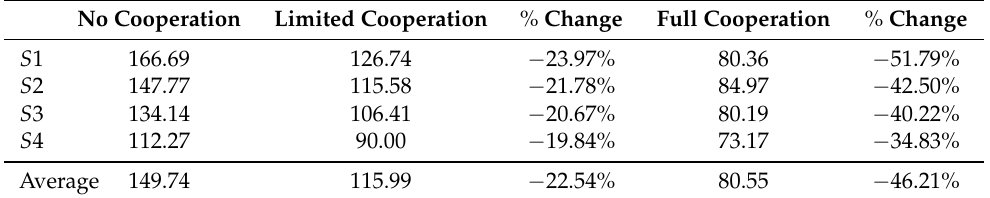
Table 4. Average lead times (minutes) in the 100 replications for non-, limited, and full cooperation settings for each